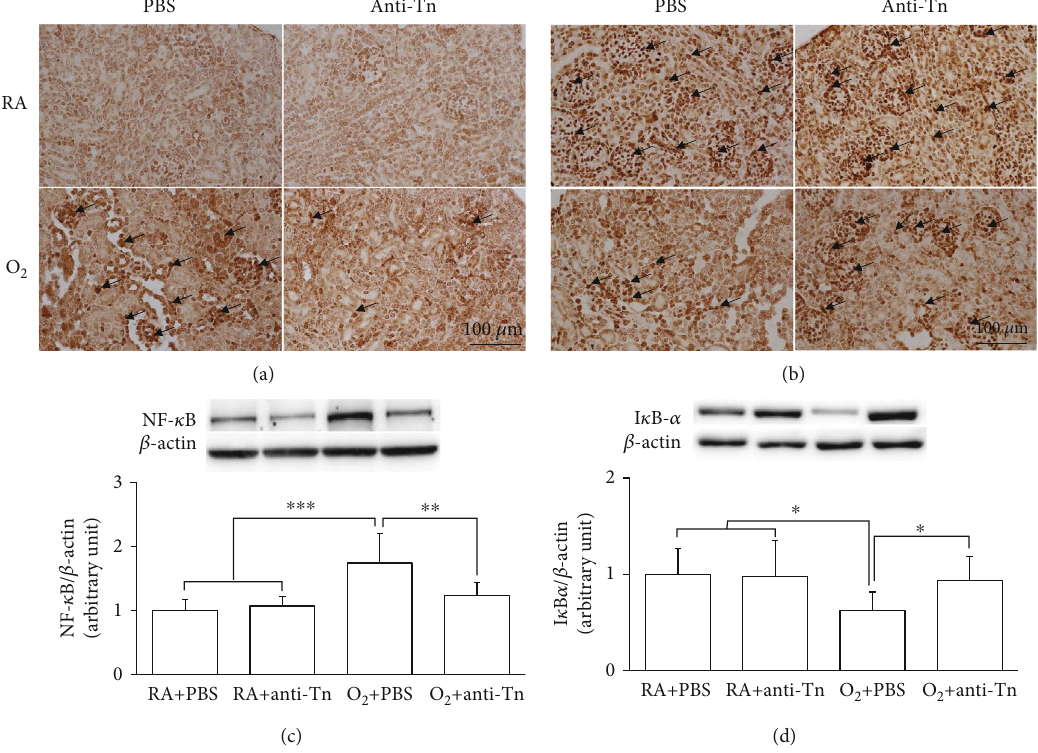
Figure 3: (a, c) Representative immunohistochemistry and (b, d) Western blot analysis of NF- κ B and I κ B- α in the RA-reared and hyperoxia-reared rats treated with PBS or anti-Tn monoclonal antibodies on postnatal day 7. The immunoreactivity of NF- κ B-p65 (black arrow) and I κ B- α (black arrow) was primarily detected in the podocytes of the glomerulus and the tubular cells of kidney tissue. The mice reared in hyperoxia and treated with PBS exhibited a higher number of positive NF- κ B-p65 and fewer positive I κ B- α cells. Anti-Tn monoclonal antibody treatment signi fi cantly reduced the hyperoxia-induced increase in NF- κ B expression and increased the hyperoxia- induced decrease in I κ B- α expression. ∗ P < 0 : 05 , ∗∗∗ P < 0 : 001